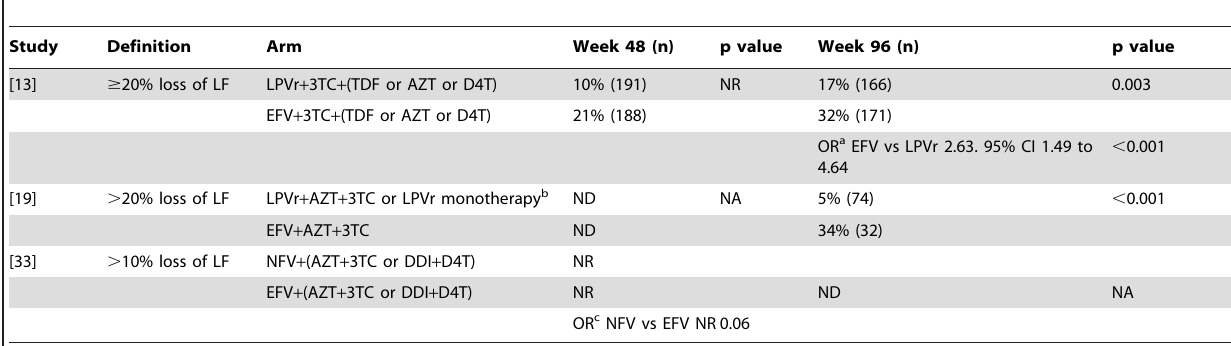
Table 8. Proportion of patients with peripheral lipoatrophy on DEXA scan: PI versus NNRTI.